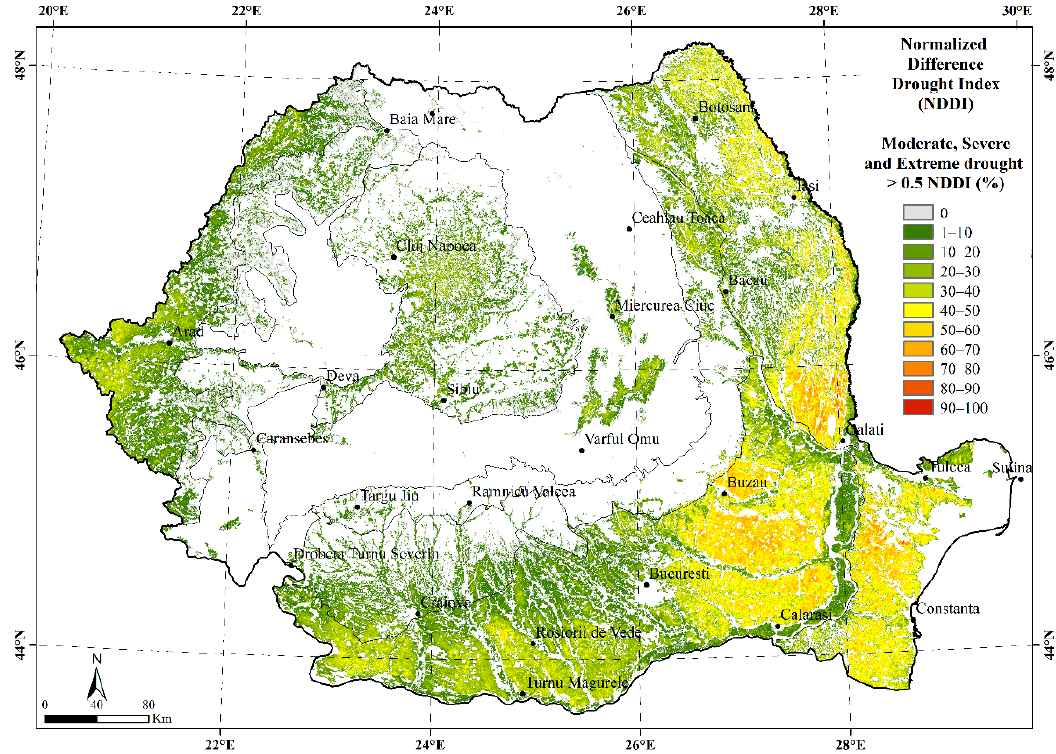
Figure 7. Spatial relative frequency of drought classes over arable lands in Romania for the seven driest years from 2001 to 2020.